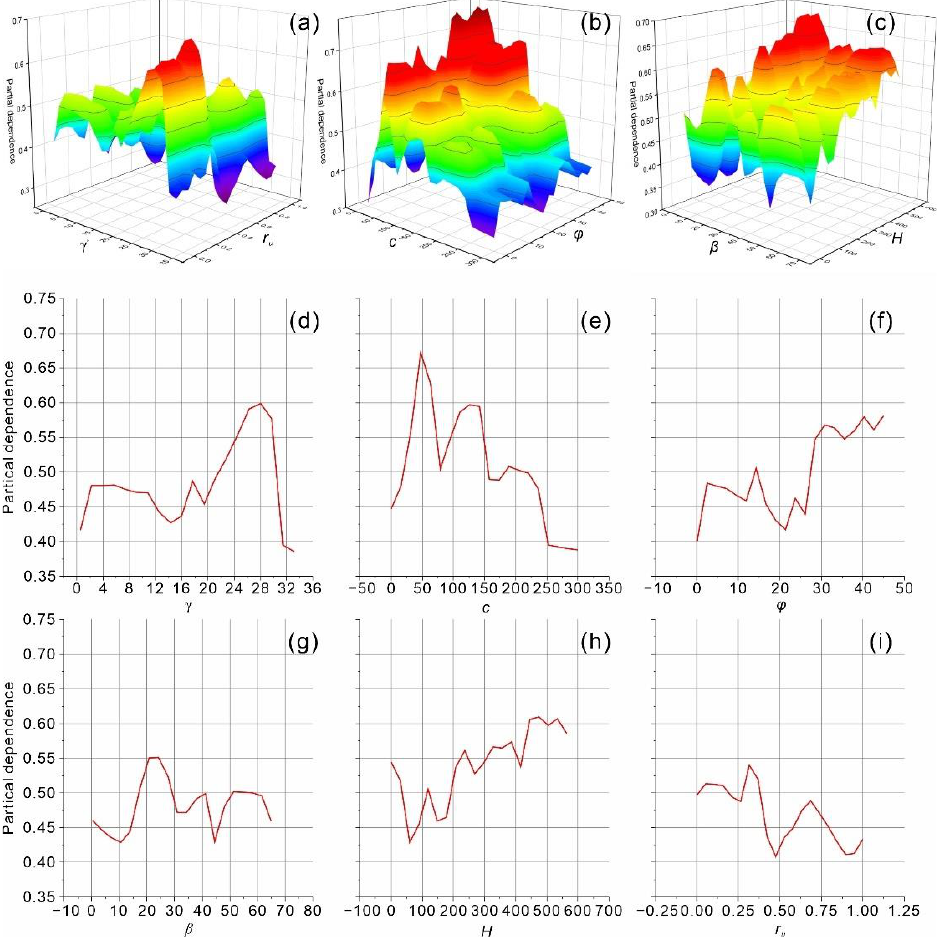
Figure 10. Partial dependence plots of the input features in the top-performing model (H2O 1 ) for the classification of slope stability. ( a ) Unit weight and pore pressure ratio, ( b ) cohesion and friction angle, ( c ) slope angle and slope height, ( d ) unit weight, ( e ) cohesion, ( f ) friction angle, ( g ) slope angle, ( h ) slope height, and ( i ) pore pressure ratio.